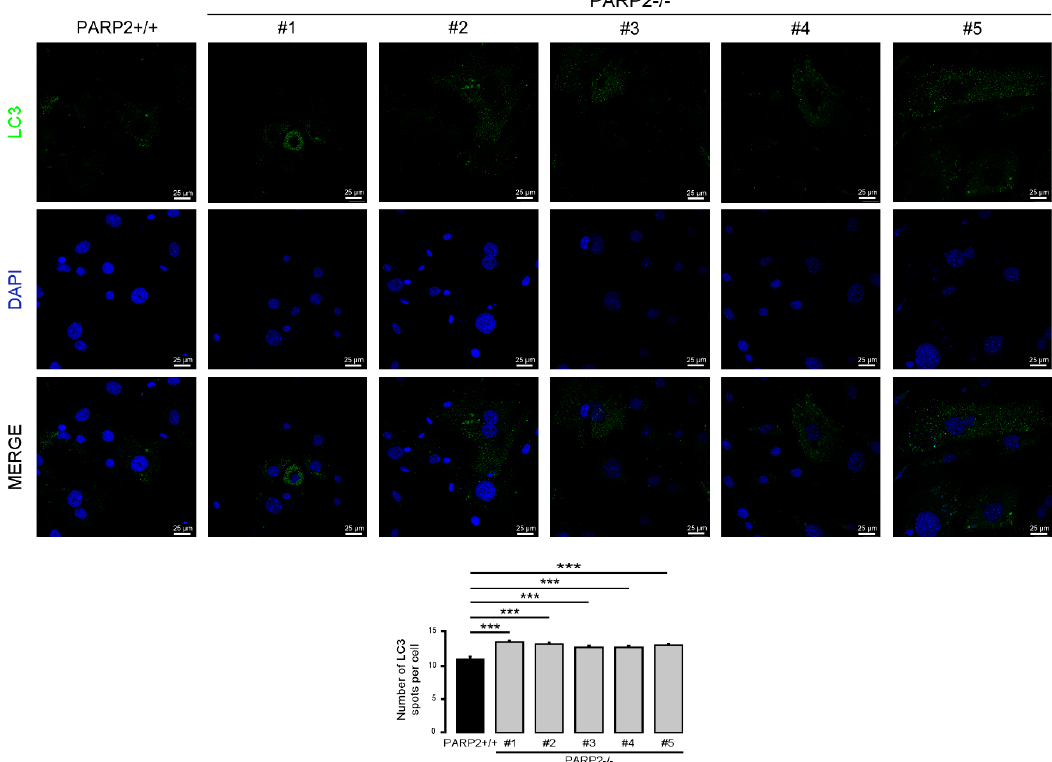
Figure 9. The number of LC3-positive vesicles in primary PARP2 knockout MEF cells. A total of 15,000 cells from the indicated primary MEF cells were seeded and were stained for Alexa Fluor 488-linked LC3 specific antibody and the nuclei with DAPI. Vesicles were counted. Representative images are presented in the figure. *** represents statistically significant differences between the PARP2 +/+ and PARP2 − / − MEF cells at p < 0.001. For the determination of statistical significance, ANOVA test was used followed by Dunnett’s post hoc test. The different numbers represent different MEF clones.